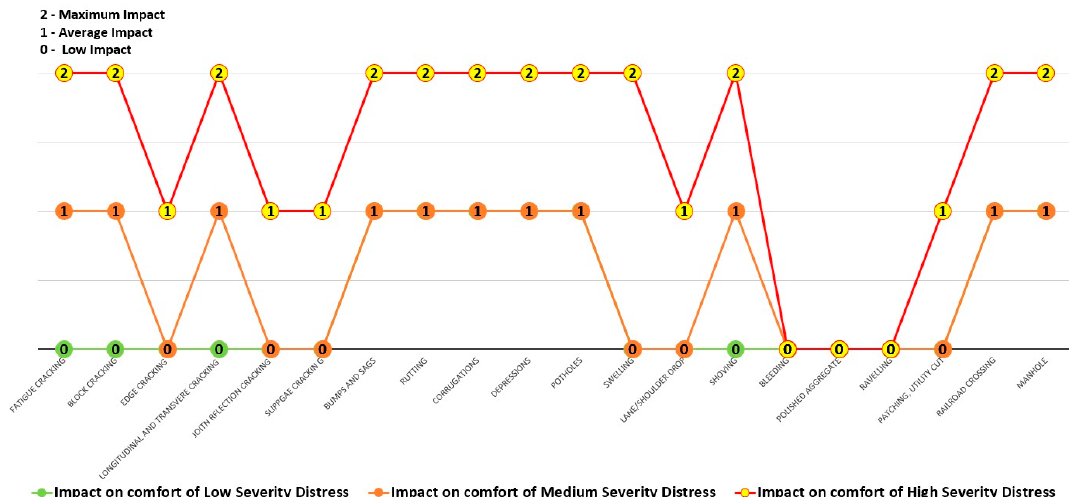
Figure 7. Impacts of the severity of pavement distresses on comfort.